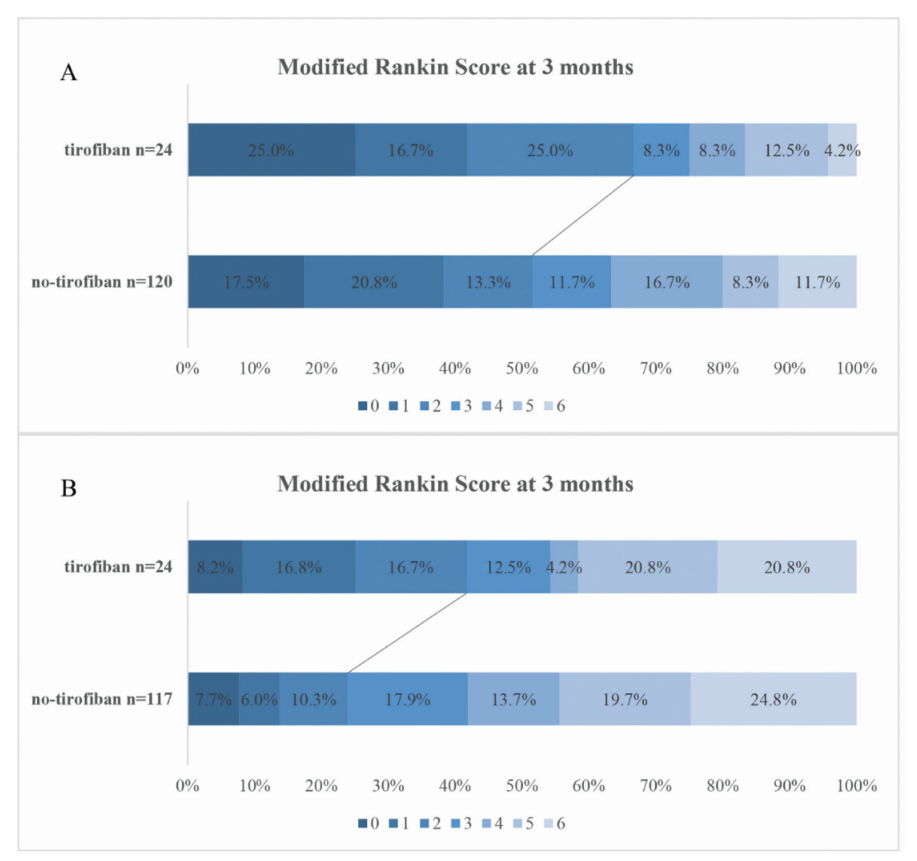
Figure 3. Distribution of mRS at 3 months categories in the patients with NIHSS ≤ 14 ( A ) and NIHSS > 14 ( B ). The lines indicate differences in favorable outcome (mRS 0–2) between groups. mRS, modified Rankin Scale.